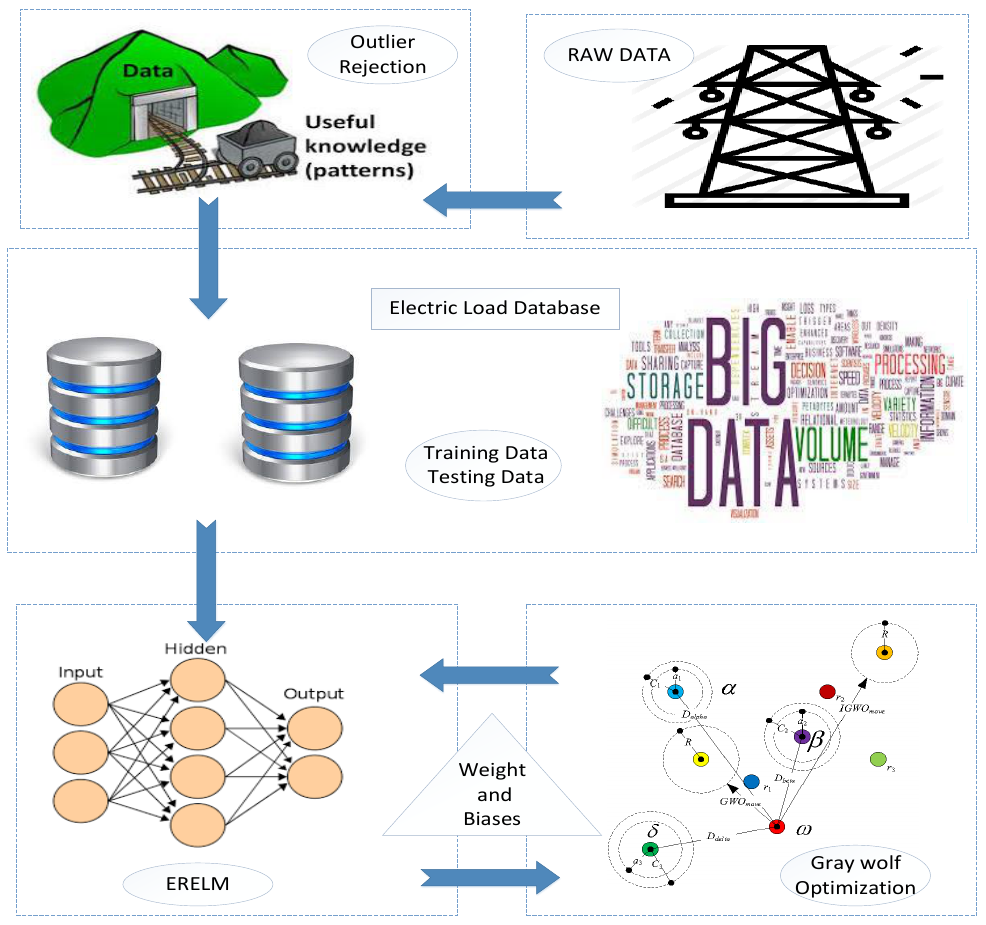
Figure 4. Proposed system model